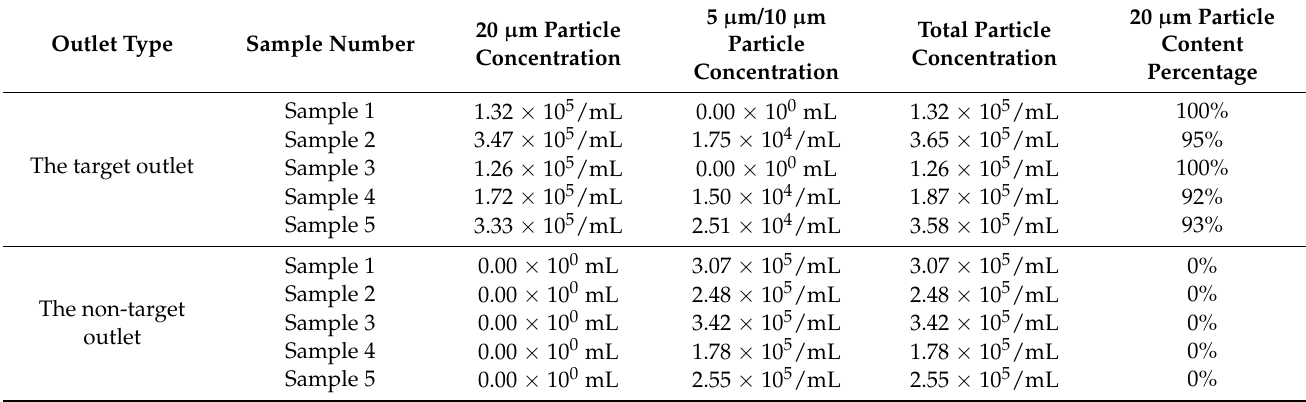
Table 1. Test statistics of particle content of each particle size in different outlets.